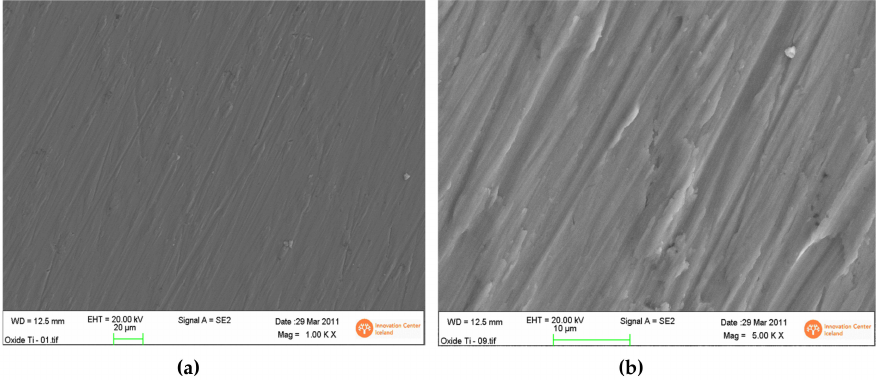
Figure 1. Surface topography after gas oxidation of titanium; two di ff erent magnifications the green bars of di ff erent magnifications of 20 µ m ( a ) and 10 µ m ( b ). The smooth traces after polishing are visible.